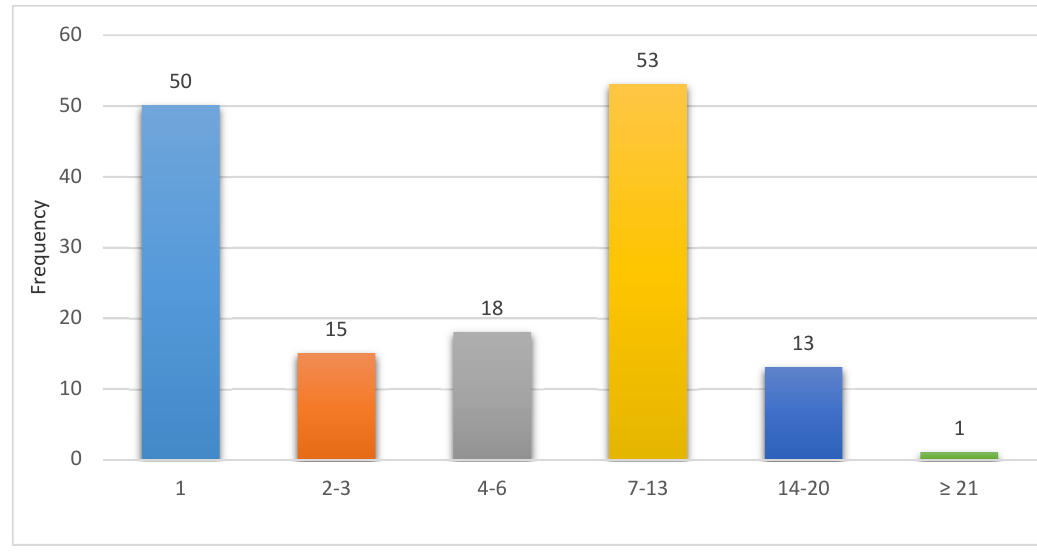
Fig 1: Duration of illness before seeking care (days) Figure 2 Duration of illness before seeking care. Figure 2 Duration of illness before seeking care. Figure 2. Duration of illness before seeking care.